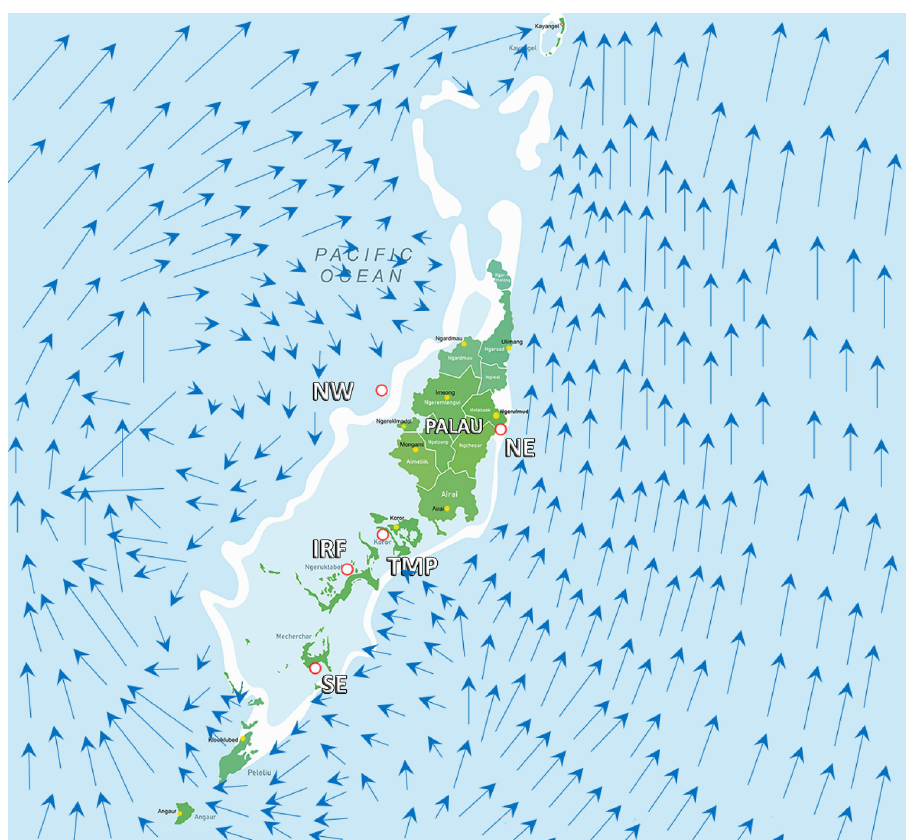
Fig 4. Model of currents around the island from the southeast, showing the effect of island mass on currents (modified from [76]).